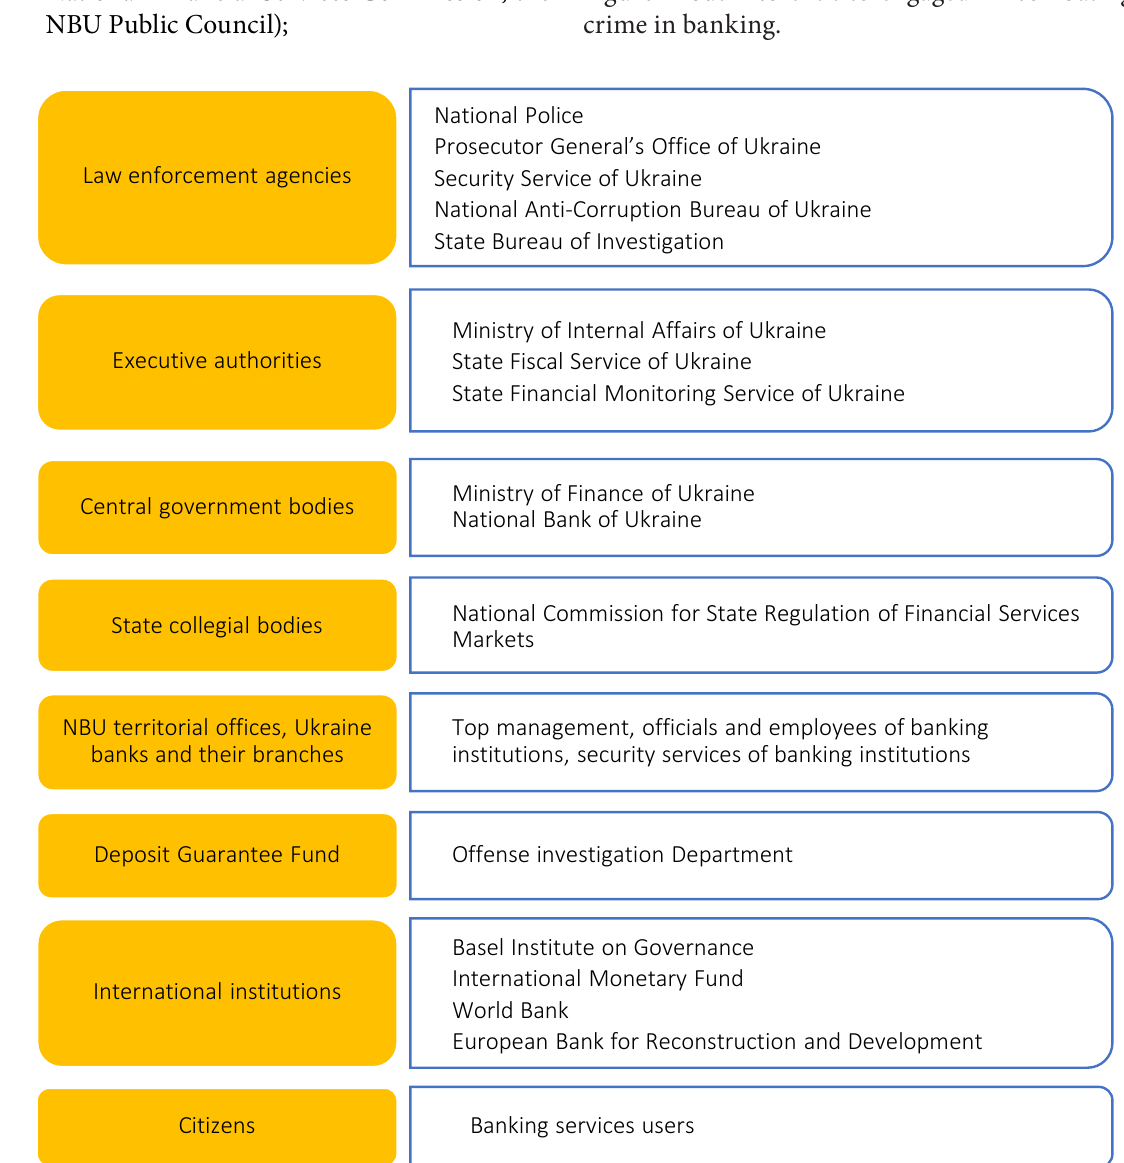
Figure 2. Entities of combating crime in banking in